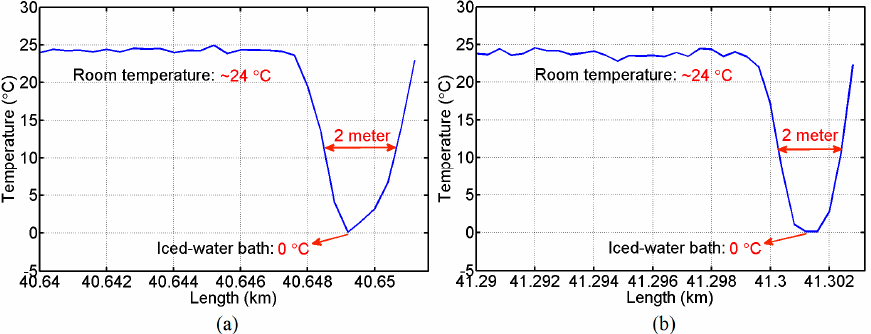
Figure 5. Temperature distribution measured with ( a ) the λ 1 channel at the far end of its sensing fiber and ( b ) the λ 2 channel at the far end of its sensing fiber.